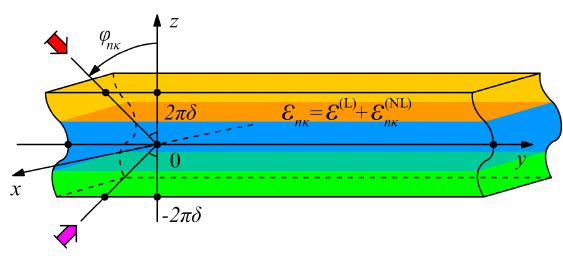
Figure 1: The plate-like structure with nonlinear layers. It is presumed that the irradiating wave packet consists of an intense field at a